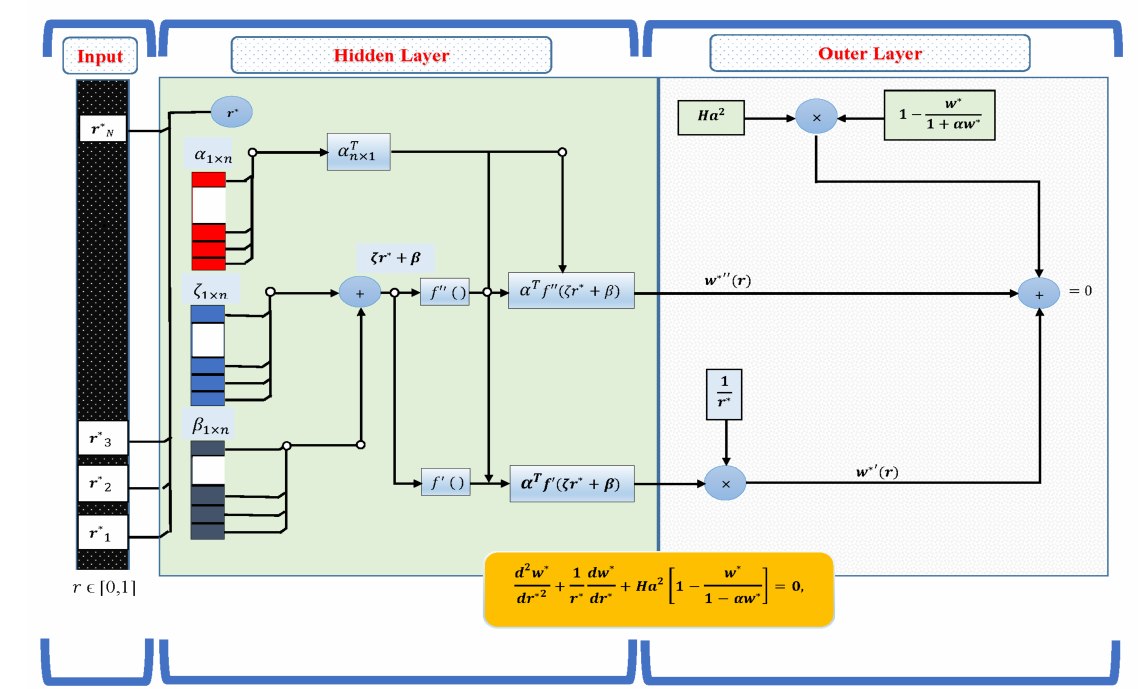
Figure 2. Architecture of ANNs for the mathematical model of the EHD flow of